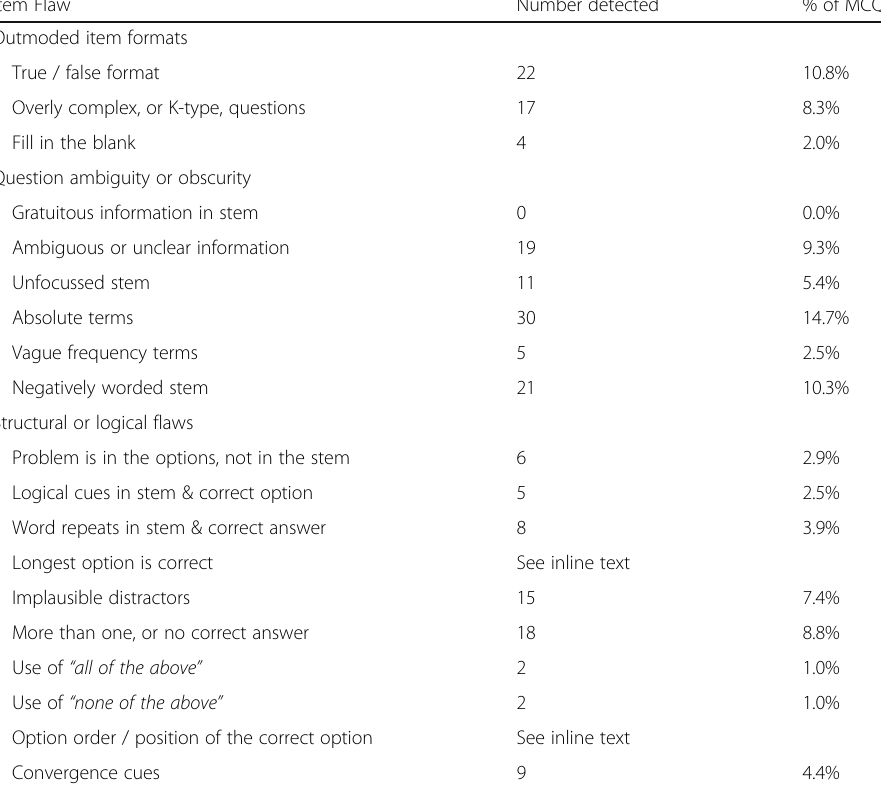
Table 2 Prevalence of item flaws in 204 MCQs from 18 MOOCs Item